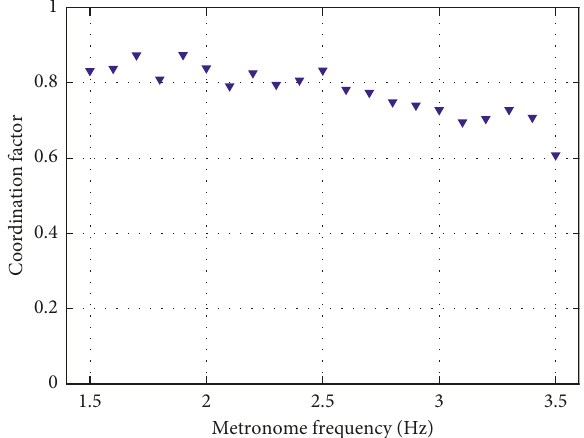
Figure 13: Summary of coordination factors identified from the peak value of the Fourier spectrum of the overall crowd and in- dividual motion for the reference configuration.